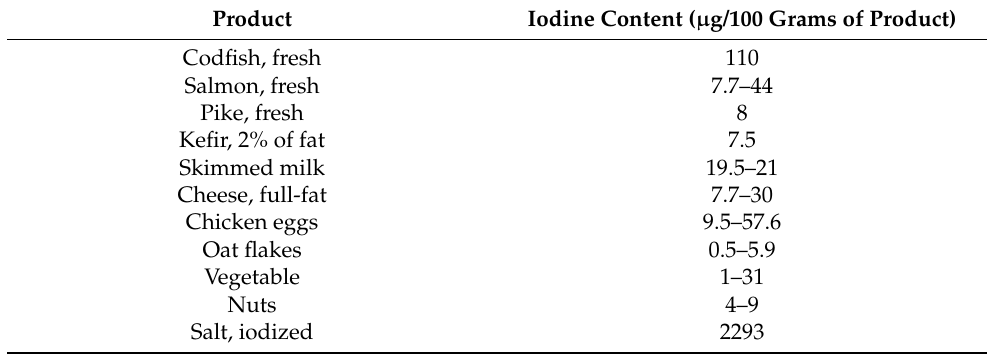
Table 2. Iodine content in the selected products.